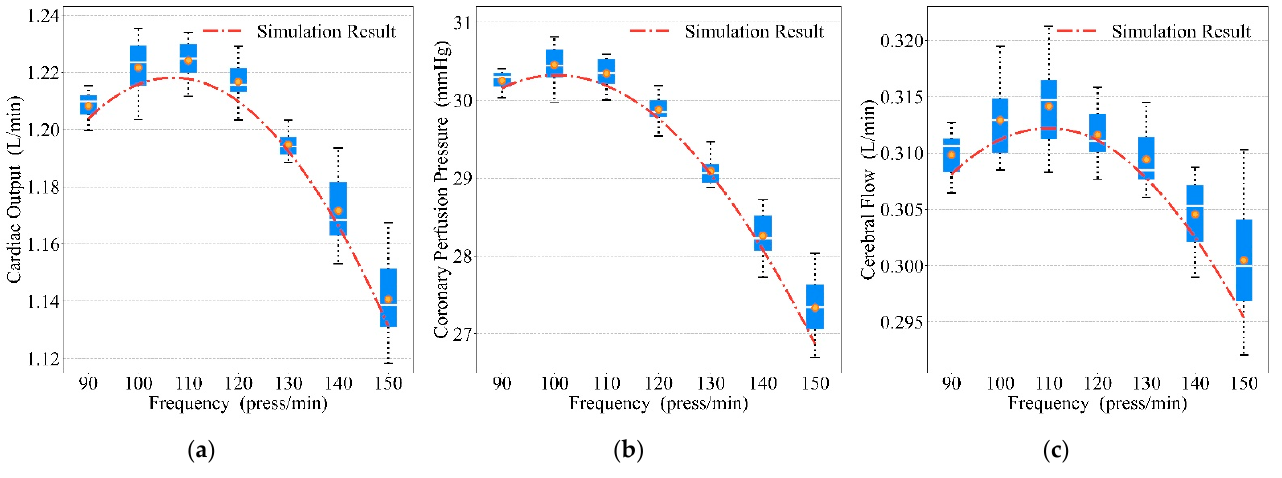
Figure 13. Relationship between frequencies and blood circulation results: ( a ) CO, ( b ) CPP, ( c ) CF.